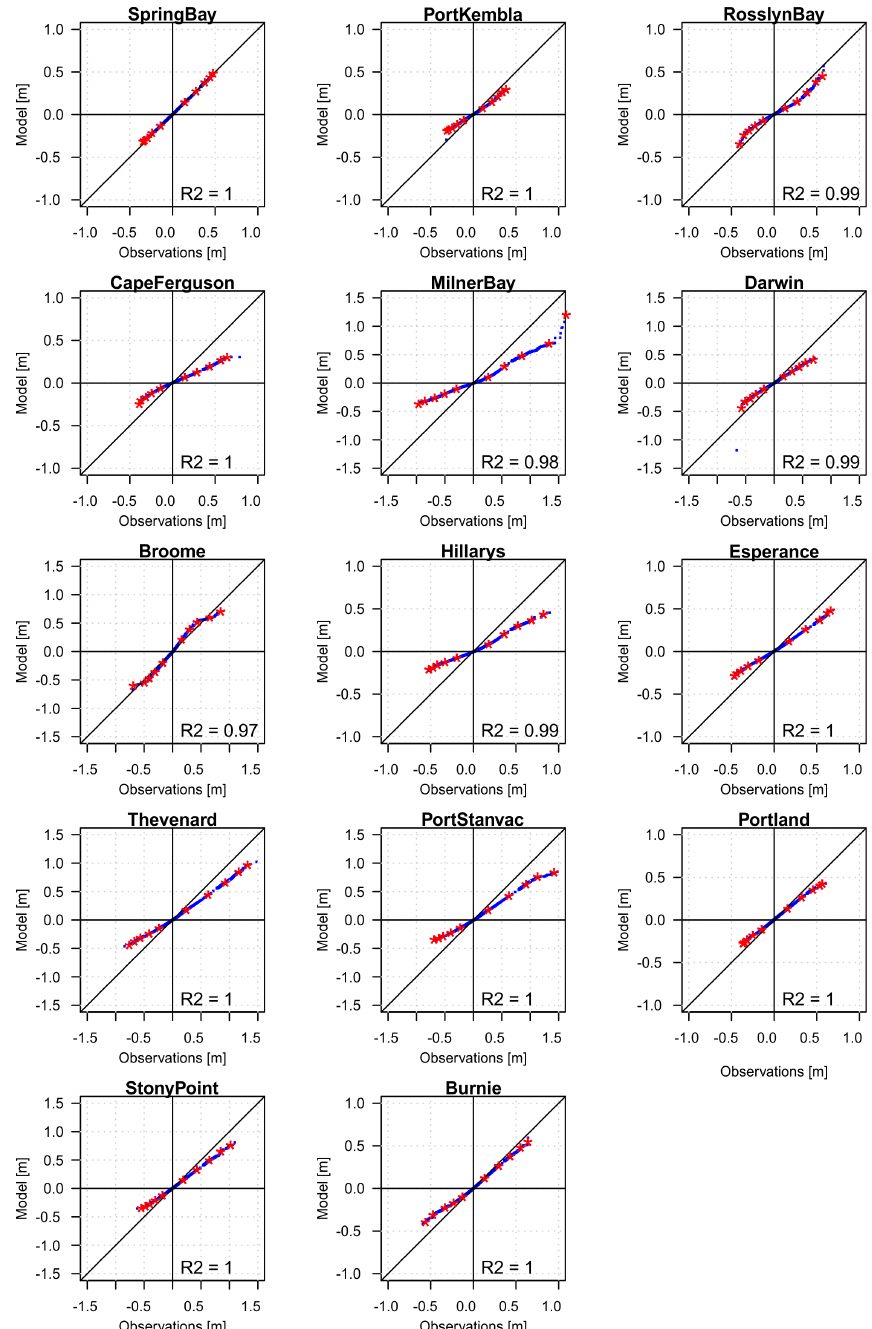
Figure 4. Quantile–quantile plots showing model-derived residuals vs. residuals from observations. The 0.01, 0.1, 1.0, 10, 90, 99, 99.9 and 99.99th percentiles are highlighted in